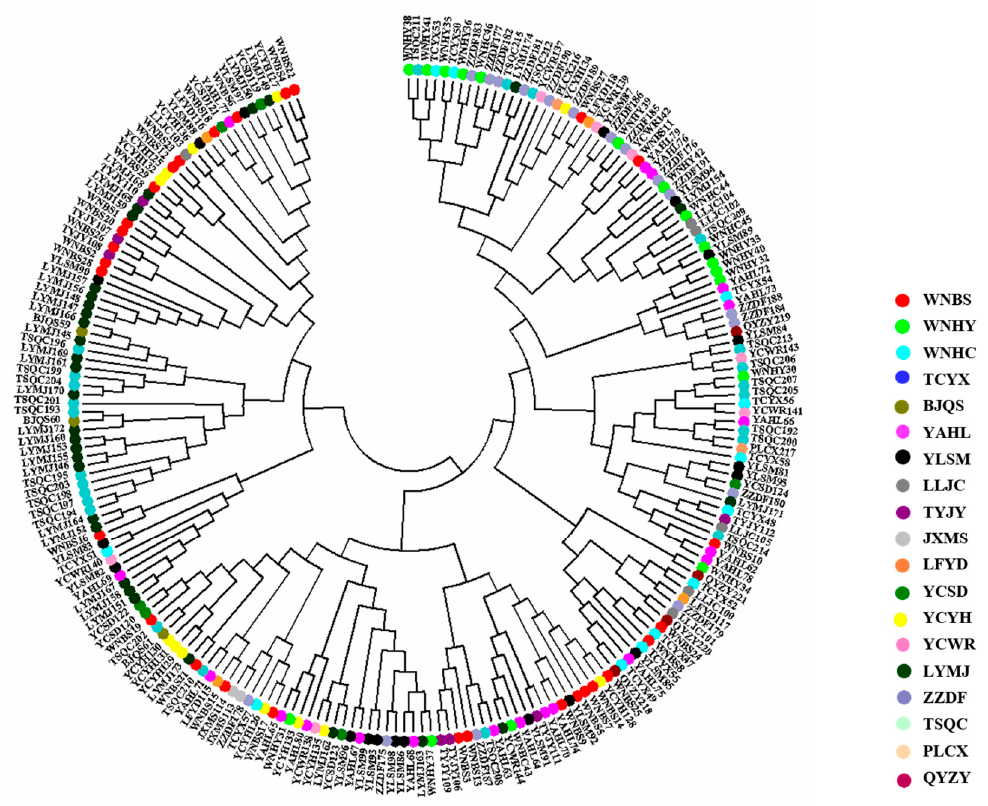
Figure 4. Neighbor-joining (NJ) tree constructed on the basis of Nei’s GDs of 221 ancient P. orientalis in the middle reaches of the Yellow River based on nine polymorphic nSSR loci.